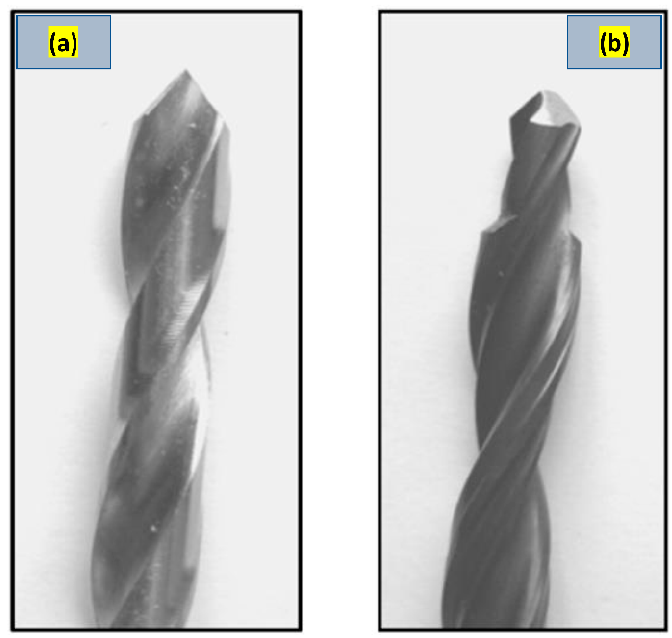
Figure 12. Standard surgical ( a ) twist drill; ( b ) two-step drill.